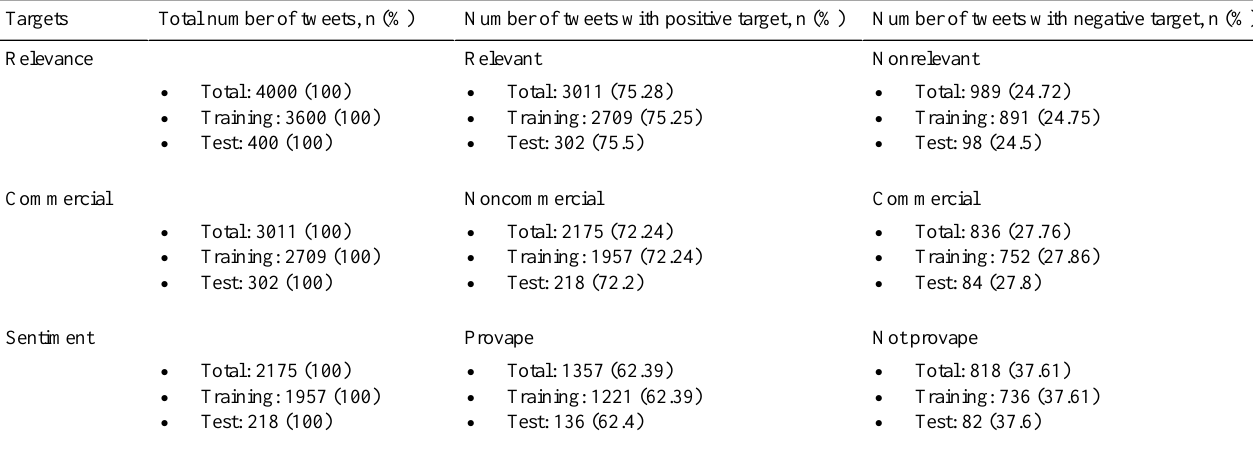
Table 3. Description of training and test data sets.